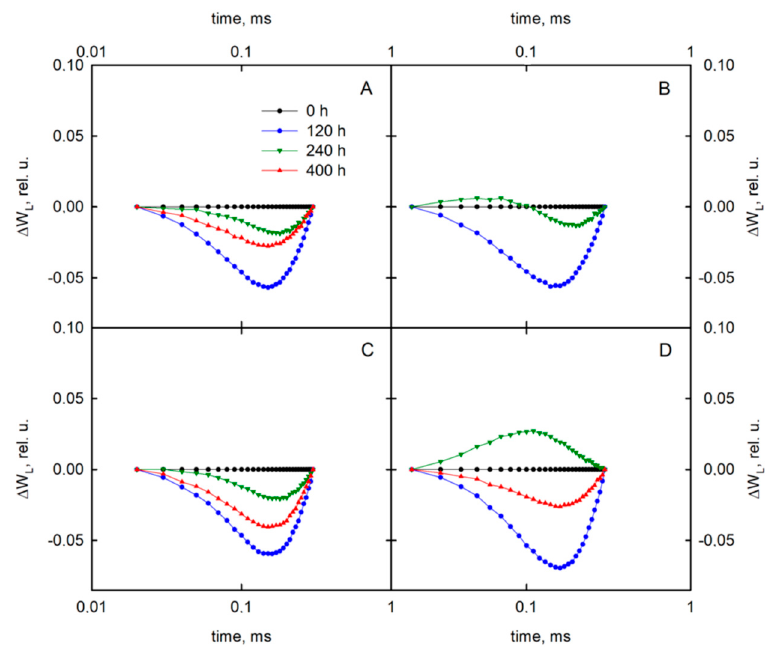
Figure A2. Di ff erential curves of ∆ W L (obtained by subtracting the control curve from the first sample in time from 0.02 to 0.3 ms) of perennial ryegrass varieties (Roadrunner and Nira) under di ff erent field water capacity of soil (50 and 30% FWC) and time (0, 120, 240 and 400 h after stress application): ( A ) Roadrunner under 50% FWC, ( B ) Roadrunner under 30% FWC, ( C ) Nira under 50% FWC, ( D ) Nira under 30% FWC. n = 6. Relative units.